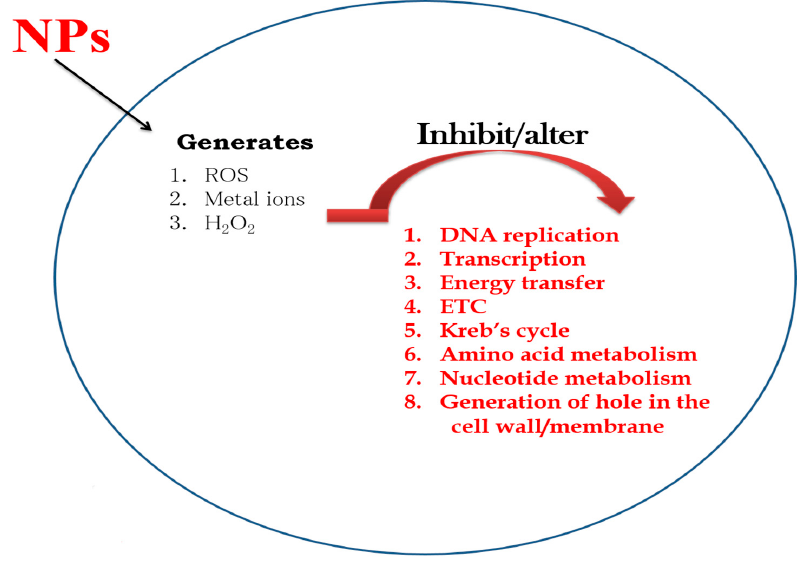
Figure 1. Mechanism of action of various nanoparticles (NPs) on microbial cells.